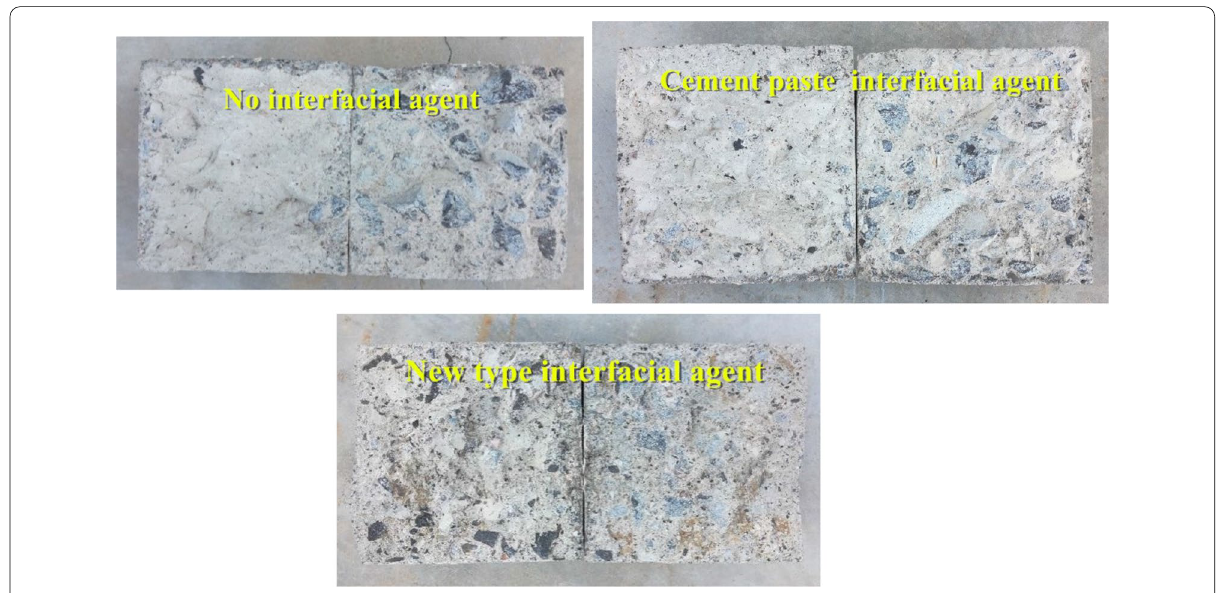
Fig. 10 Fracture surfaces of the bonding